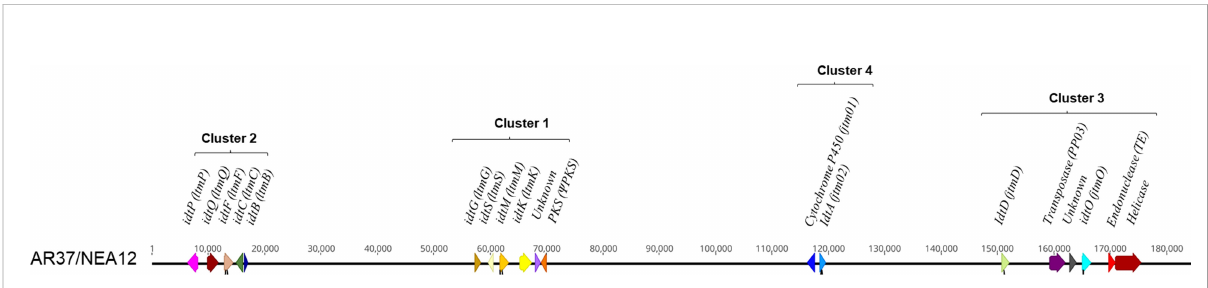
FIGURE 1 A comparison of syntenic analyses between AR37 and NEA12 epoxyjanthitrem biosynthetic clusters. Simpli fi ed gene location for epoxyjanthitrem, a group of indole diterpenes in Epichloë sp. LpTG-3 strain AR37 and NEA12. Identi fi cation and comparison of the genetic region containing the gene clusters proposed to be involved in the production of epoxyjanthitrem compounds in AR37 and NEA12. Genes are depicted as coloured arrows with direction indicating the direction of the gene transcription, size proportional to the gene size, and colour indicating gene homology. Either the given name or function is labelled above the gene, with gene names in brackets referring to corresponding genes in Ludlow et al. (2019). Black lines under the arrows indicate the guide locations. The row of numbers are the base pairs across the